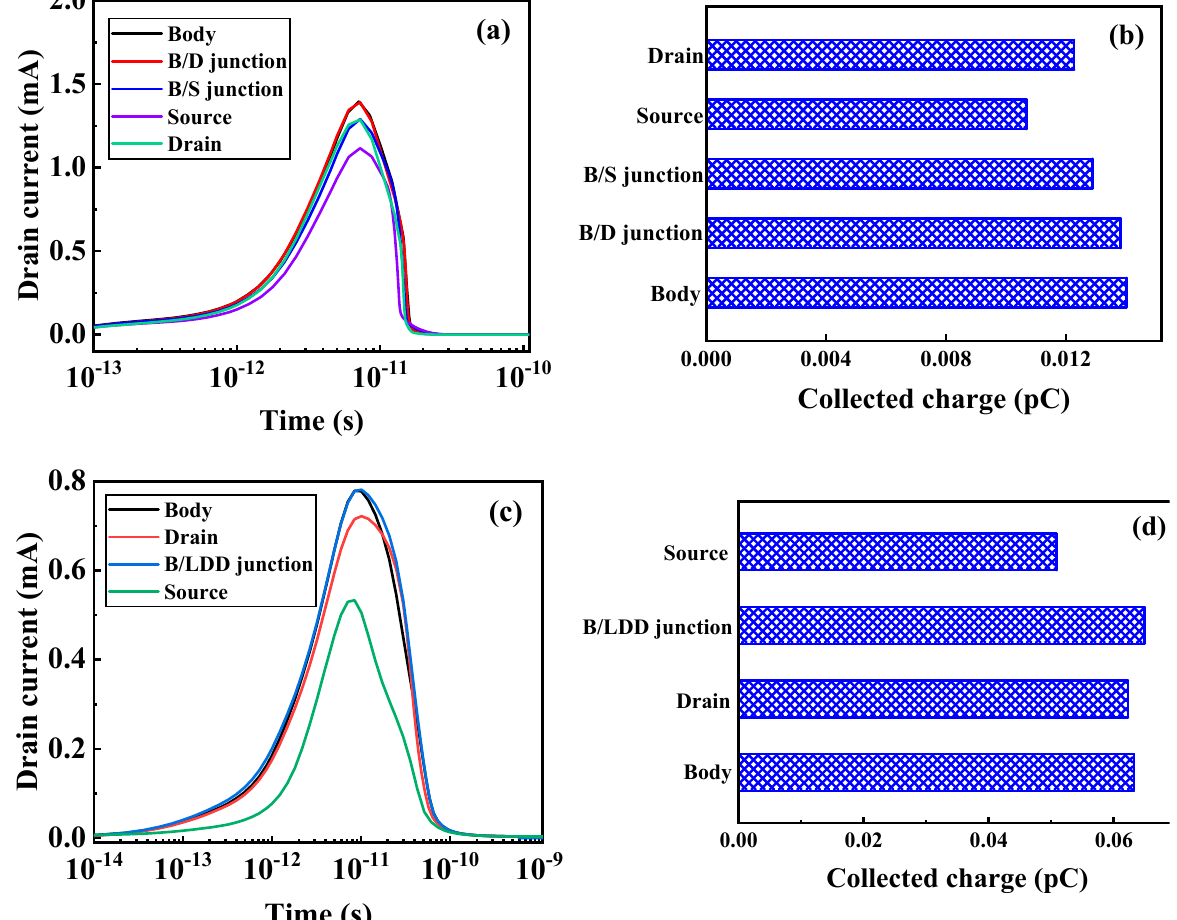
Figure 5. Simulated ( a ) drain transient currents and ( b ) collected charges for five vertical ion hit locations in DGTFET, and ( c ) drain transient currents and ( d ) collected charges for four vertical ion hit locations in FDSOI at LET = 100 MeV · cm 2 /mg and V d = 0.5 V.